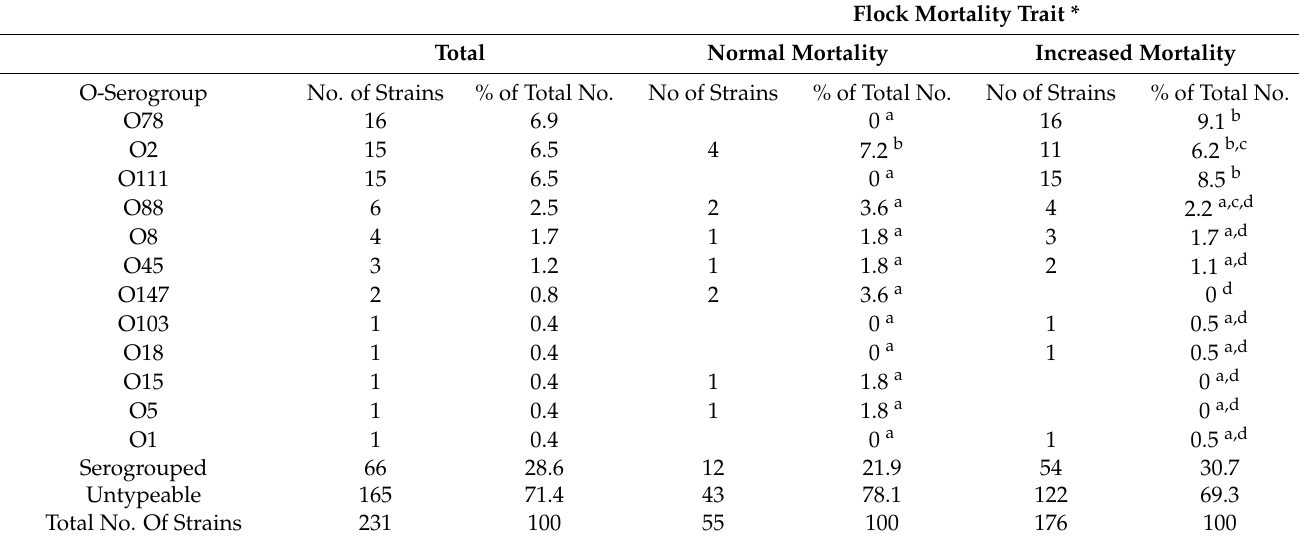
Flock Mortality Trait